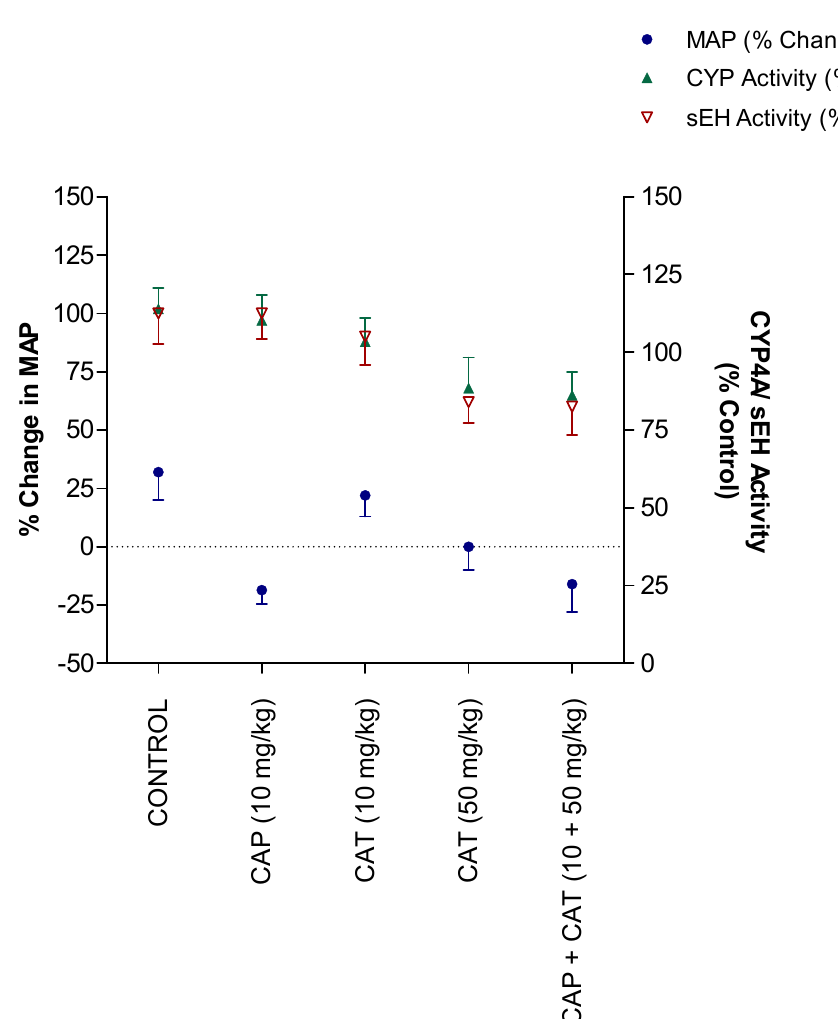
Figure 6. The % changes in mean arterial blood pressure (MAP) and enzymatic activity of CYP4A and sEH activity as a function of different doses of catechin (CAT) and captopril (CAP) in spontaneously hypertensive rats (SHR). Treatment rats received CAP and/or CAT in their drinking water at different concentrations for 5 weeks. Control rats received drinking water